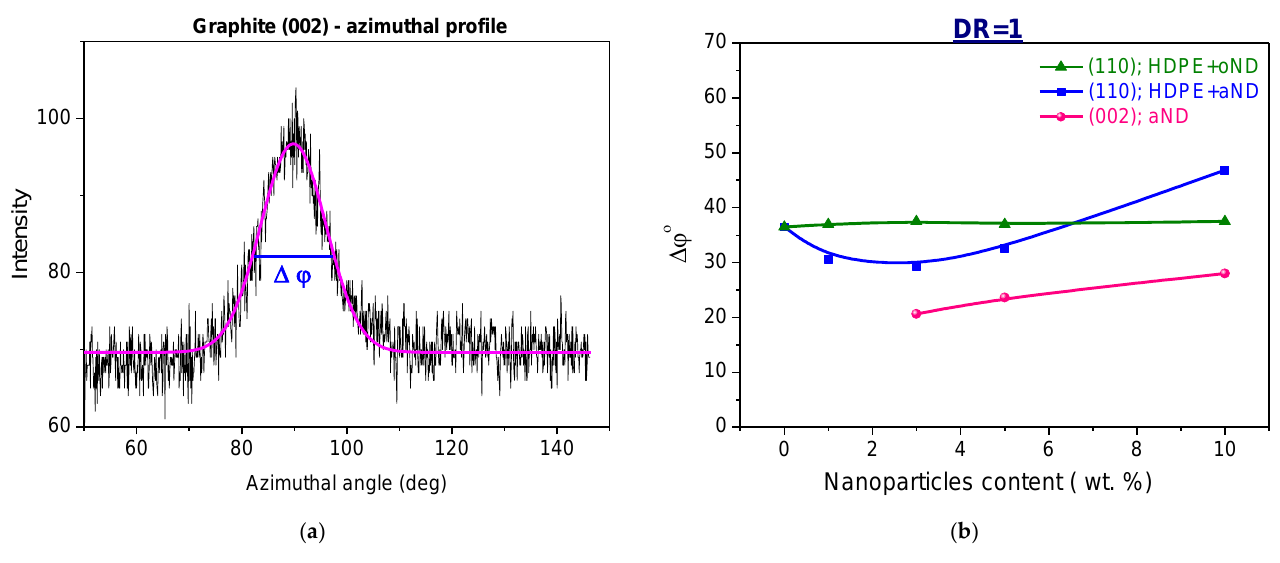
Figure 11. ( a ) An example of an azimuthal profile of the graphite 002 reflection of the aND nanoparticles (black line – experimental data; magenta line – computer fit line); ( b ) misorientation degree ( ∆ φ ◦ ) of the HDPE crystalline regions depending on the nanofiller content in the unoriented fibers (DR = 1).